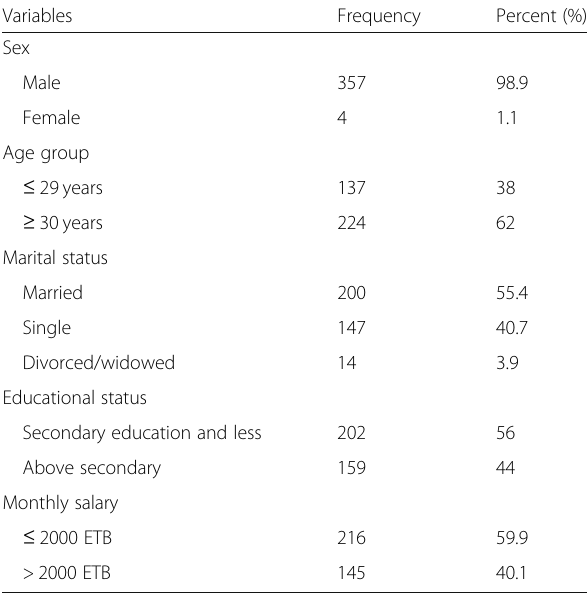
Table 1 Sociodemographic characteristics of drivers in Bahirdar city, Ethiopia, 2016 ( N = 361)